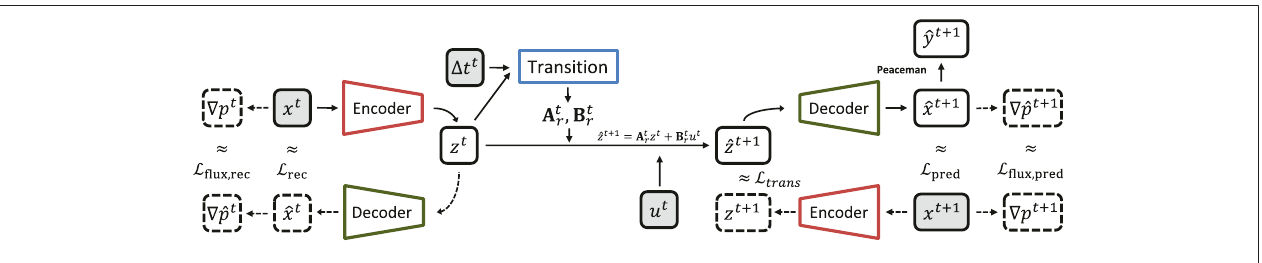
FIGURE 3 | Diagram for training the E2C with fl ux